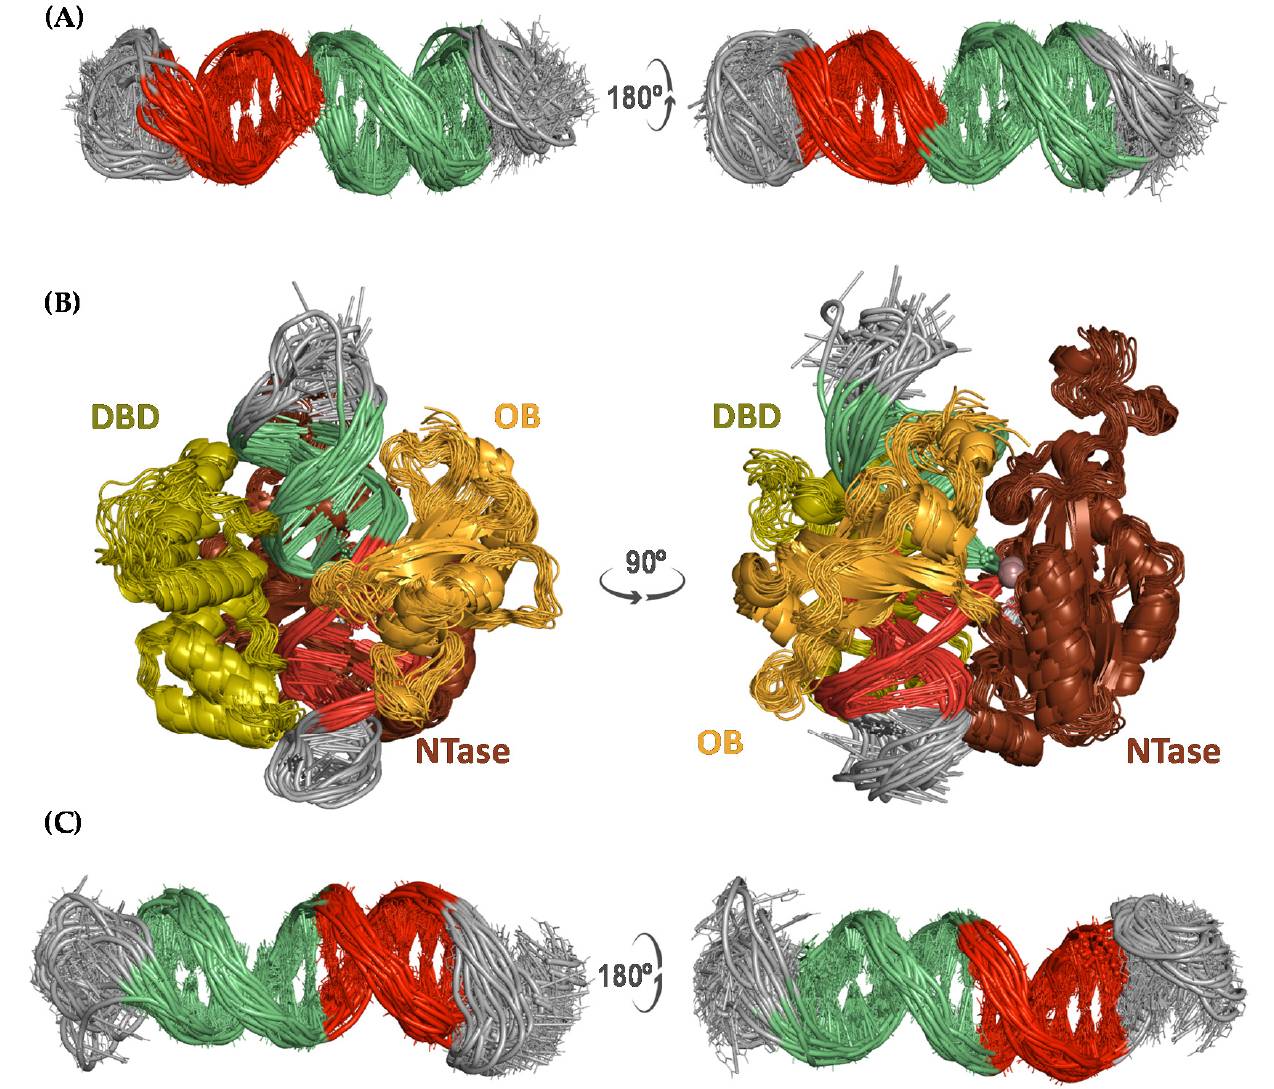
Figure 2. Cartoon representation of an ensemble of 40 structures from two viewpoints (left and right) taken from the uMD trajectories of ( A ) the nicked dumbbell, ( B ) the nicked dumbbell in complex with T4 DNA ligase, and ( C ) the hairpin with a dangling 3 ′ -end. Snapshots separated by 5 ns were obtained from the post-equilibrated 100–300 ns interval of each trajectory. Self-complementary strands are colored in red and green whereas single-stranded regions are colored in grey. The three T4 DNA ligase domains are labeled as DBD (DNA binding domain, residues 1 ─ 129), OBD (oligonucleotide-binding domain, residues 370 ─ 487) and NTD (nucleotidyl-transferase domain, residues 133 ─ 367), and colored in green, orange and brown, respectively. The Mg 2+ ion is shown as a violet sphere.